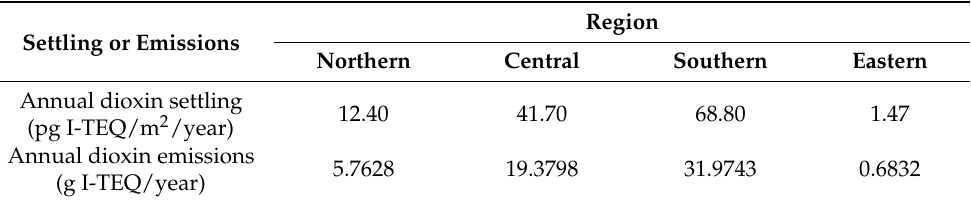
Table 1. Annual dioxin settling simulated by the Taiwan EPA for each region and the corresponding distribution of dioxin emissions across regions. Source: